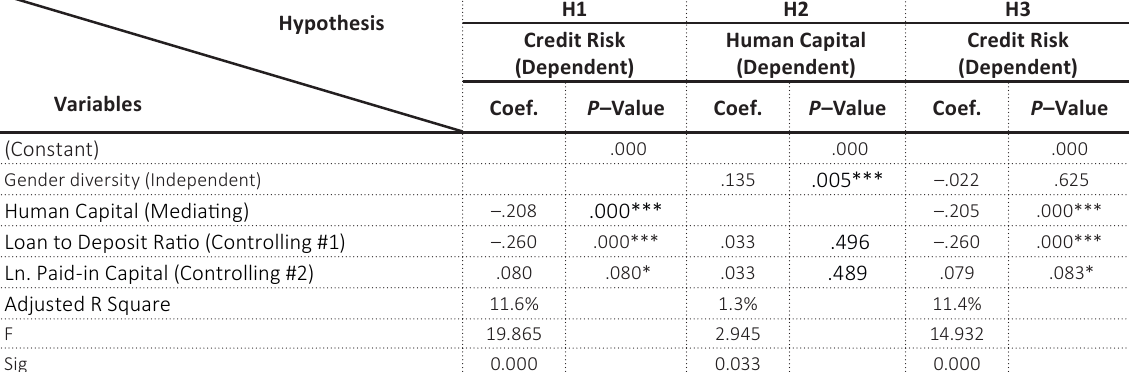
Table 3. Hypothesis testing